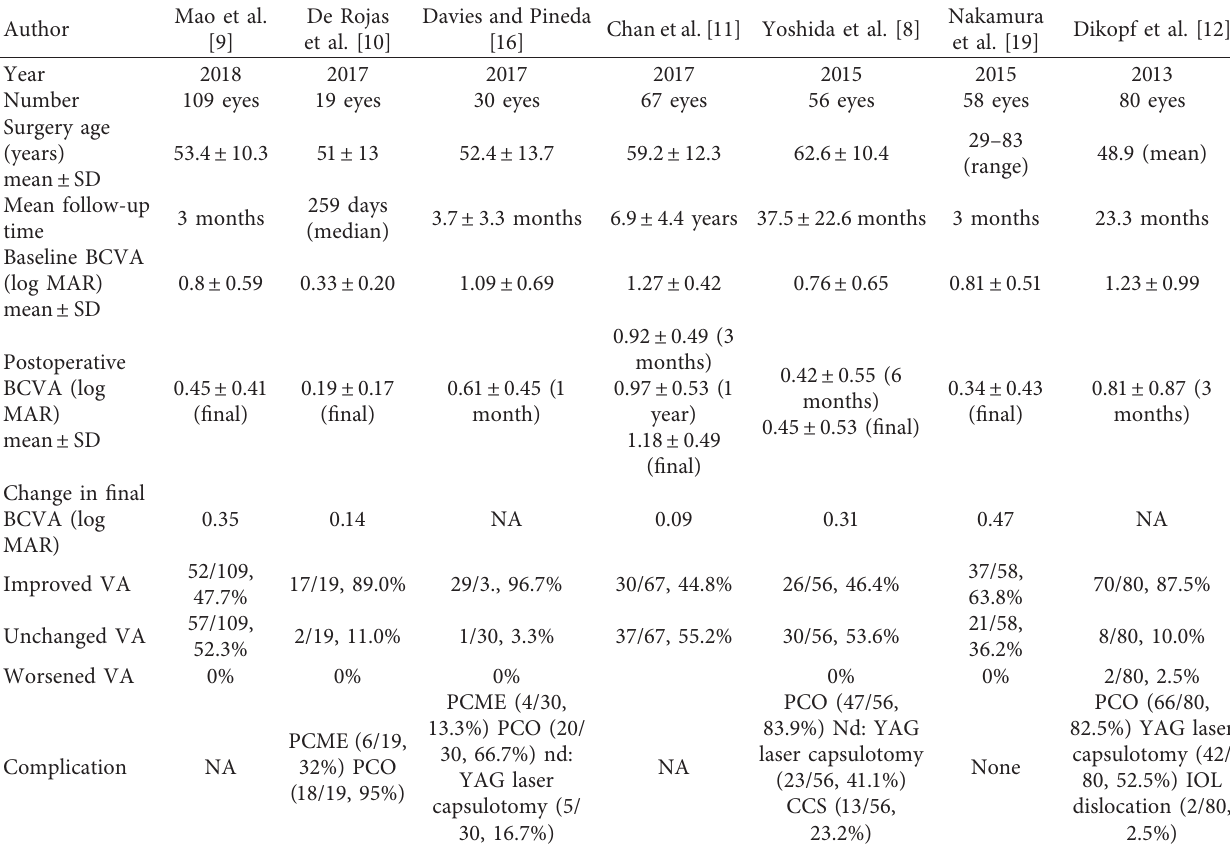
Table 2: Overview of phacoemulsification with IOL implantation outcomes in RP patients for the last decade. Author